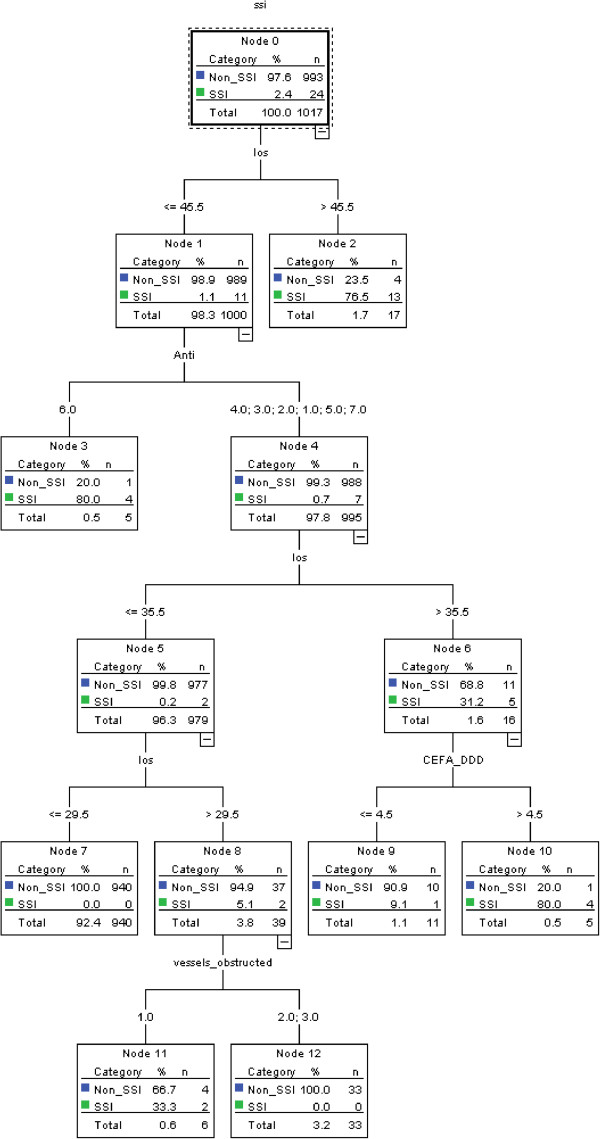
Decision tree model for identifying cases of CABG surgical site infection. SSI: surgical site infection; los: length of stay; Anti: type of antibiotics; CEFA_DDD:dosage of cefazolin; vessels_obstructed: number of vessels obstructed.